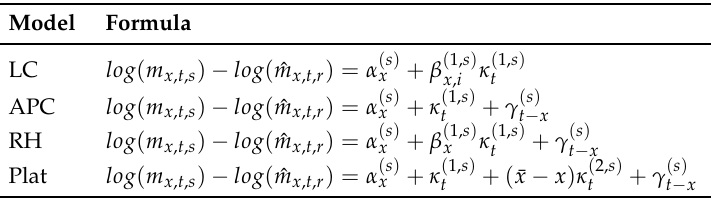
Table 5. Mortality models for the Spread.